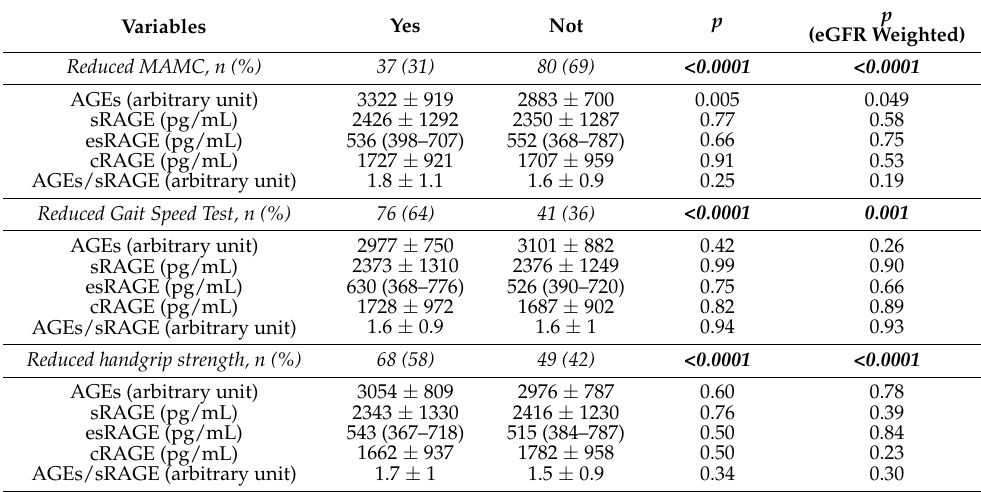
Table 3. Concentration of AGEs and sRAGE isoforms classified according to the presence (yes) or absence (not) of alterations in the sarcopenic domains.